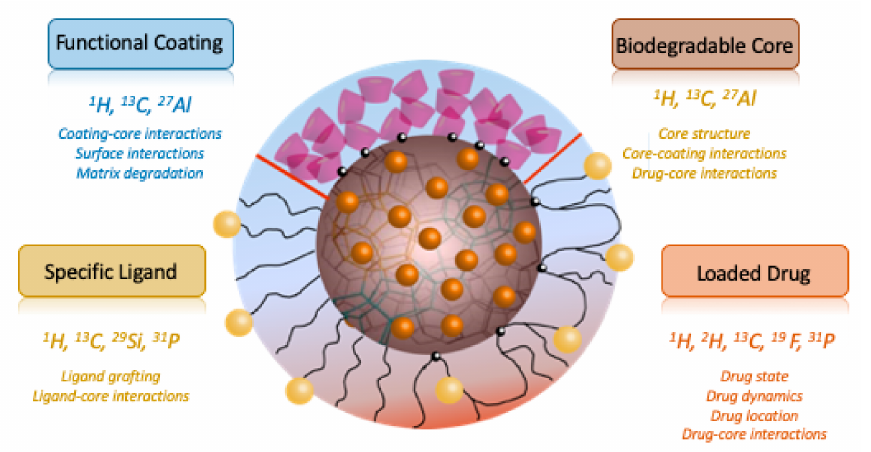
Figure 1. Scheme of a DDS nanoparticle containing a core, in which the drug is loaded, functional coating, and specific ligand. The nuclei of interest in ssNMR and the information that can be extracted from these measurements are